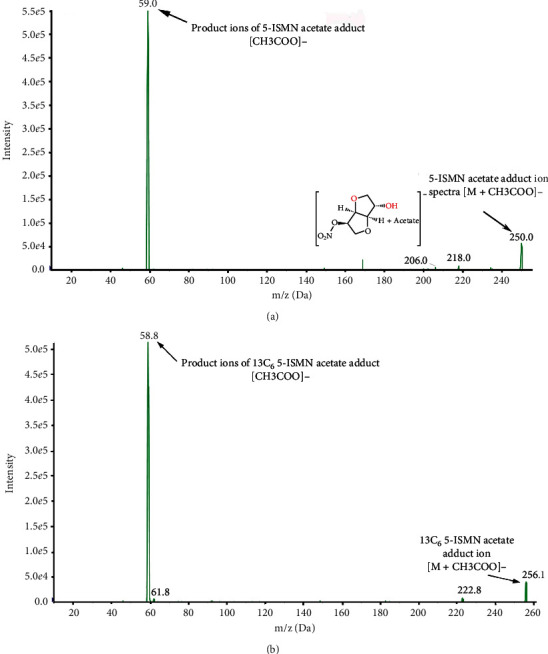
Product ion spectra of 5-ISMN (a) and IS (13C6-5-ISMN) (b).